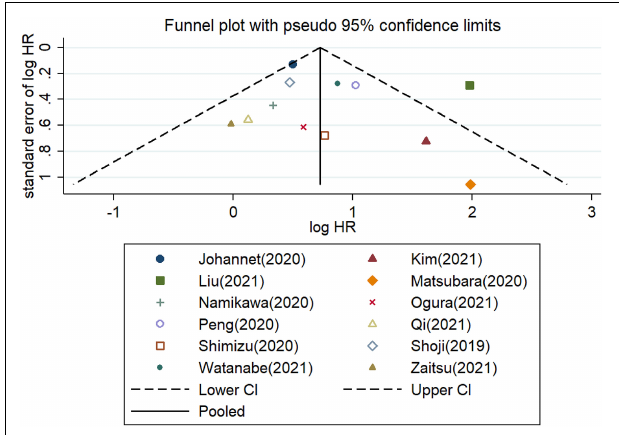
FIGURE 1 | The literature search